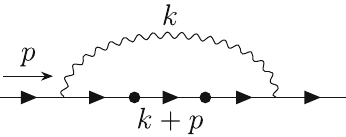
Fig. 3 Self-energydiagramwithtwo f vertexinsertionsontheinternal fermion